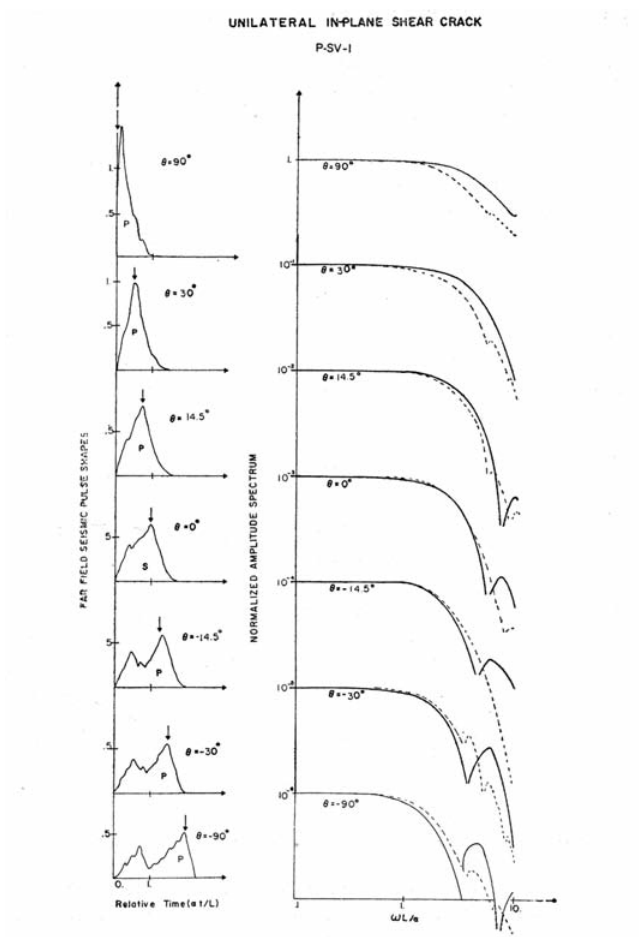
Figure 5. The far-field wave form is shown for P waves for various azimuths on the left for case P – SV – 1. The arrows indicate the arrival of the stopping phase from the moving crack tip. The absolute value of the Fourier transform of the far-field wave form is shown on the right in a logarithmic scale normalized to the value at zero frequency. For comparison, the dashed lines on the figure of the spectrum show the curves for case P – SV – 0. Reproduced from Das and Aki [1977].